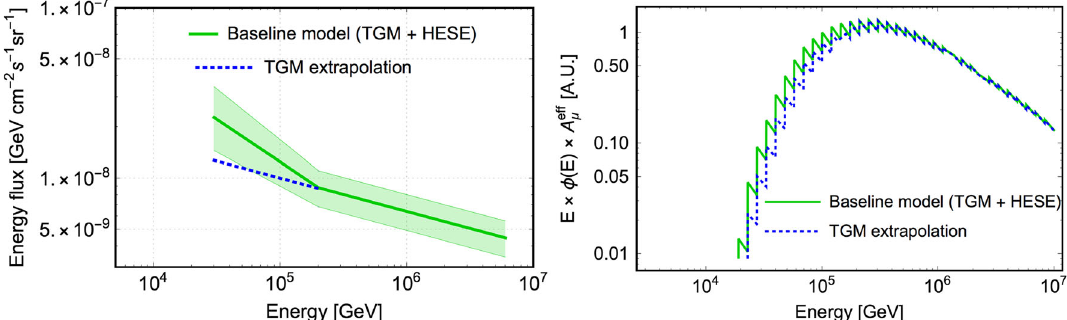
neutron decay (right panel). In the last case there is overlap between the fraction of ν μ and ν τ at Earth and the two distributions are not distinguishable in the figure